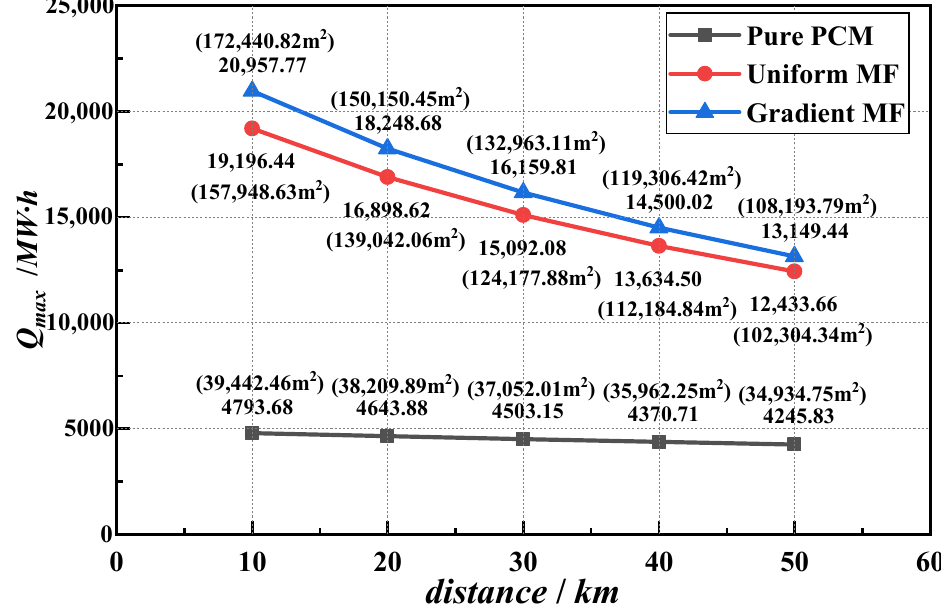
Figure 5. The maximum heating capacity varies with distance under three structures.